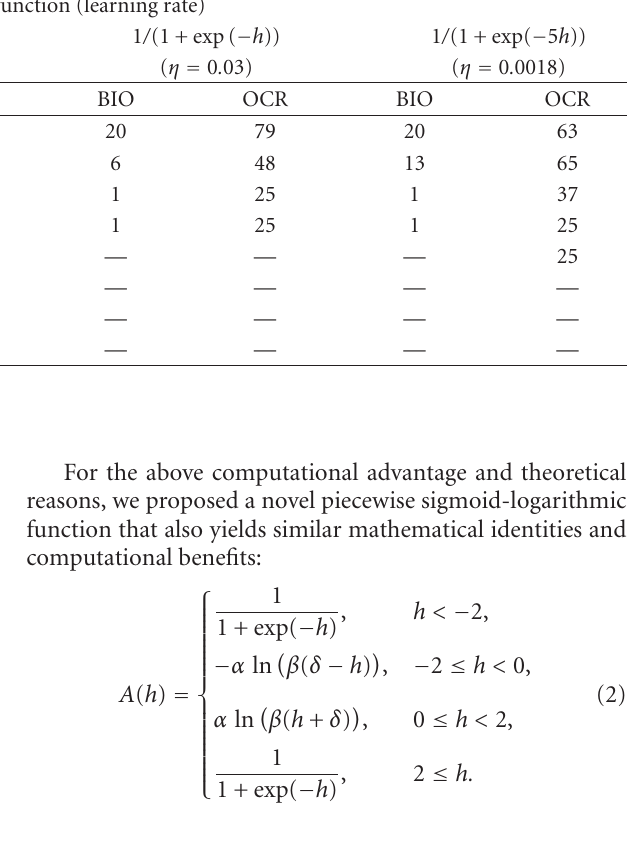
Table 1: Biosignature and OCR recognition results (Unit: counts of patterns correctly recognized in one test dataset. OCR: each test dataset contains 100 characters. BIO: biosignature recognition task, each test dataset contains 20 patterns.) Transfer function (learning Gray level to original data